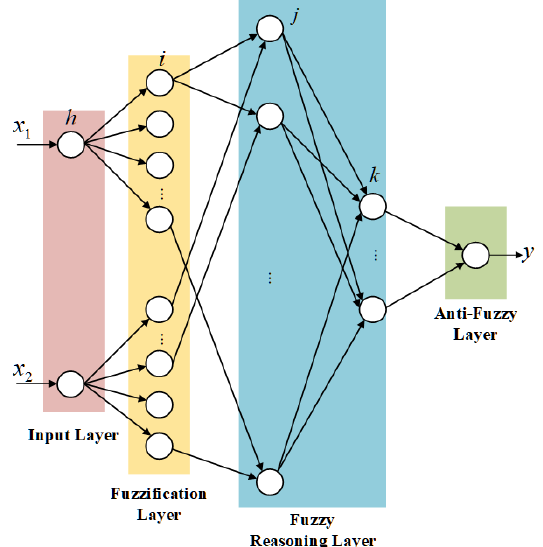
Figure 9. Typical structure of fuzzy neural network.